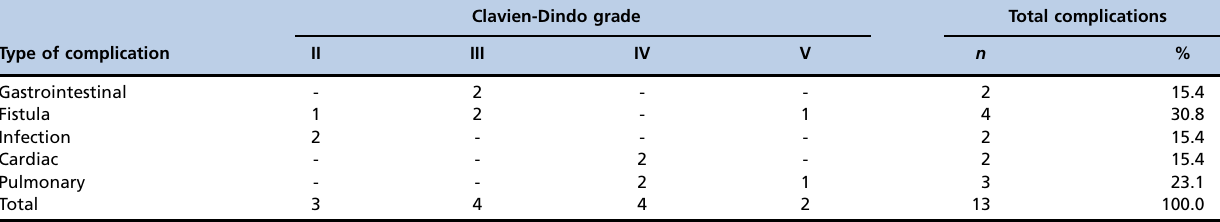
Table 4 - Postoperative complications of curative GC in the COVID group.